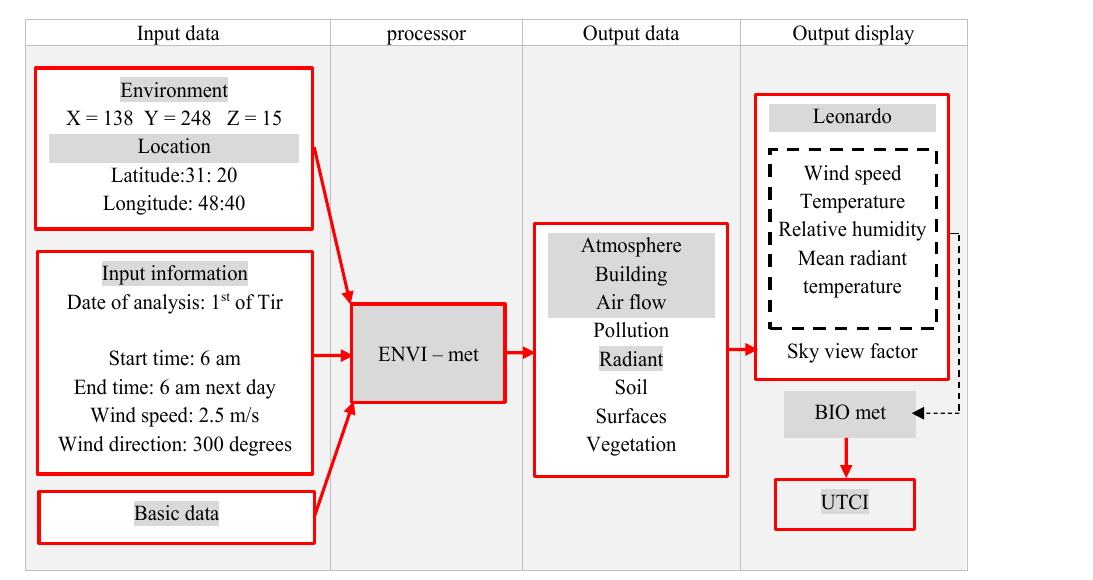
Figure 3. Procedure method and input